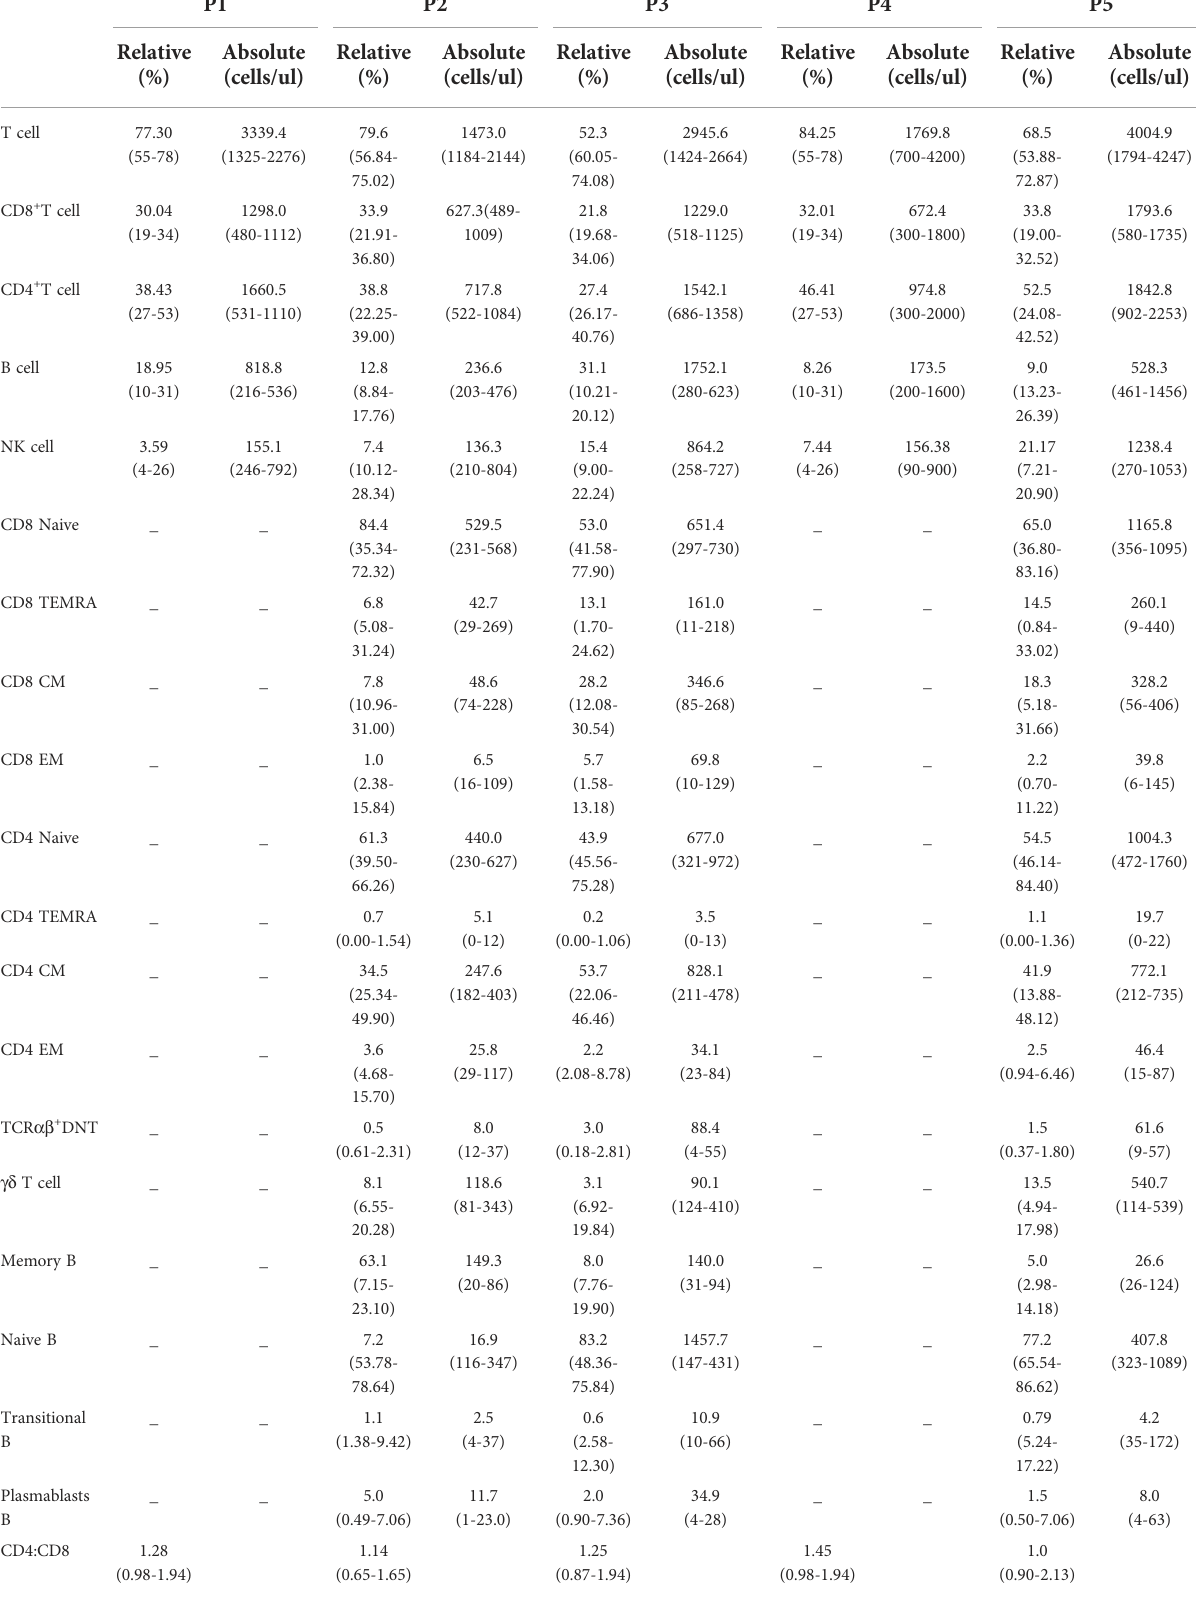
TABLE 2 Lymphocyte classi fi cation of patients with IPEX